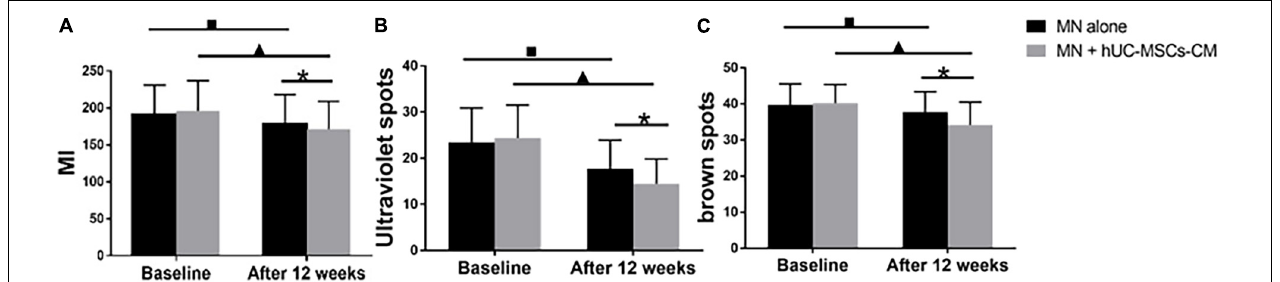
FIGURE 3 | Objective non-invasive skin pigmentation measurements. (A) Melanin index (MI); (B) Ultraviolet spots; (C) Brown spots. MN: microneedling; hUC-MSCs-CM: human umbilical cord-derived mesenchymal stem cells conditioned media. * P < 0.05, post-treatment comparison between MN alone and MN plus hUC-MSCs-CM; (cid:78) P < 0.05, pre-treatment and post-treatment in MN plus hUC-MSCs-CM. (cid:4) P < 0.05, pre-treatment and post-treatment in MN alone.